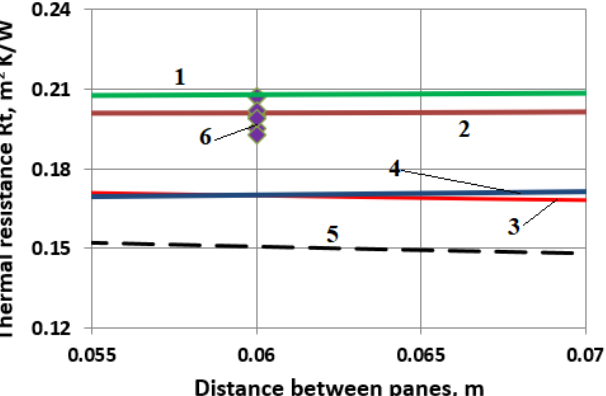
Figure 8. Comparison of the calculated thermal resistance values R t of double-glaze pane windows with experimental data from IET NAS of Ukraine: 1—results of calculations in the CFD ANSYS Fluent package; 2—results of calculations in the CFD Star CCM package; 3—results of calculations from the one-dimensional model; 4—results of calculations from Formula (2) with correction (3), where χ = 0.105Ra 0.3 ; 5—calculation results from Equation (2) with correction (3), where χ = (1 + (0.03303Ra 0.402 ) 11 ) 0.091 ; 6—experimental data from IET NAS of Ukraine—February–March 2015.